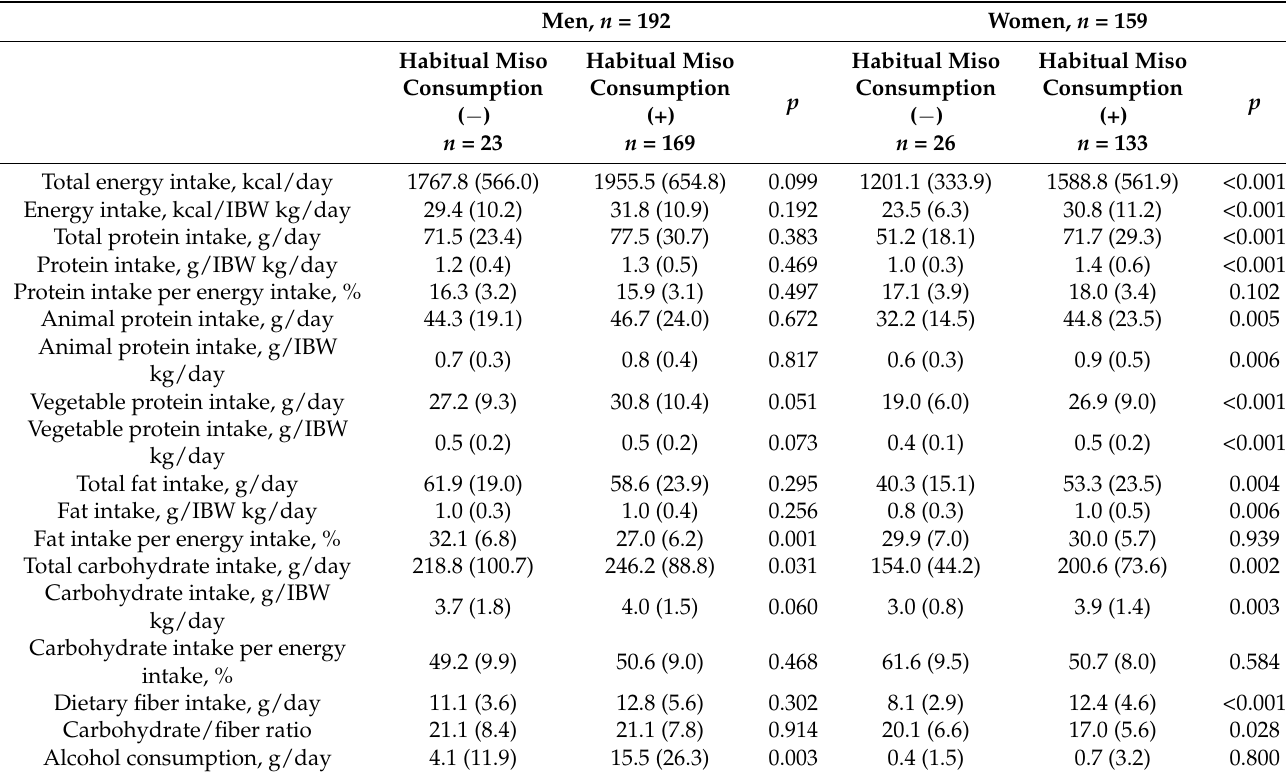
Table 4. Habitual diet intake according to habitual miso consumption.